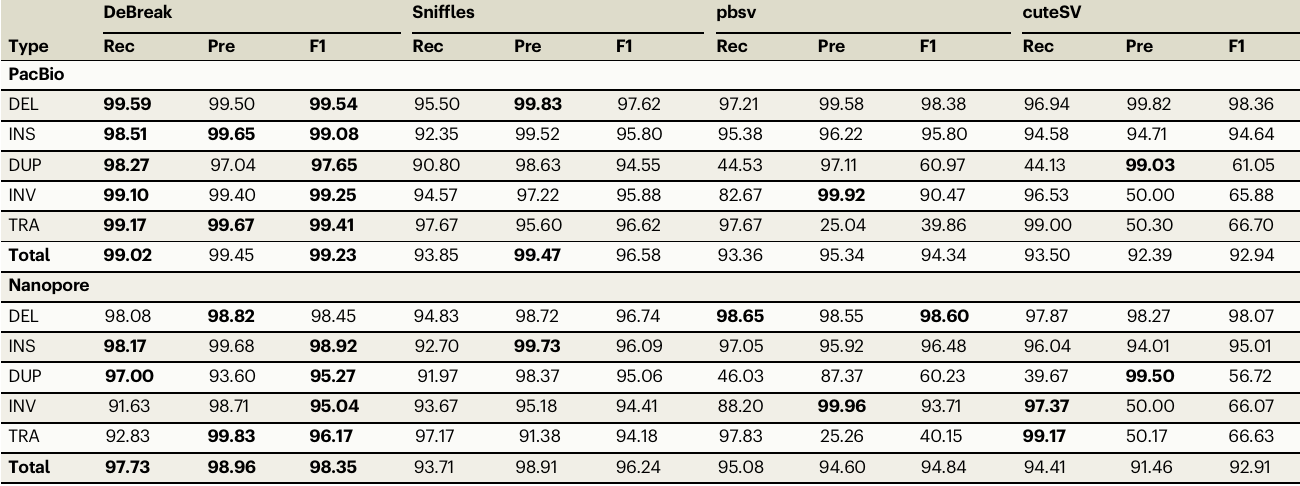
Table 1 | SV discovery accuracy on simulated datasets